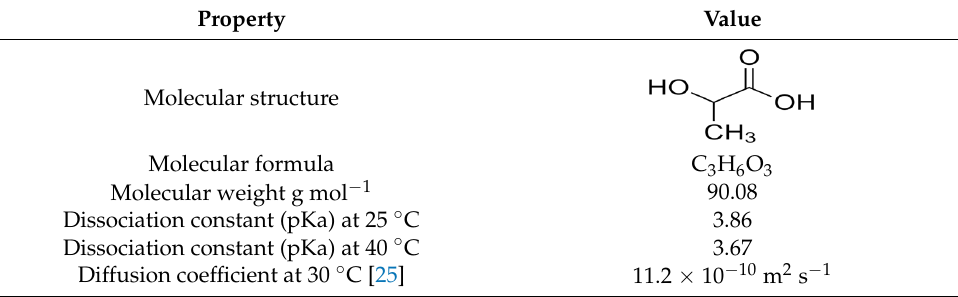
Table 1. Physicochemical properties of the lactic acid.